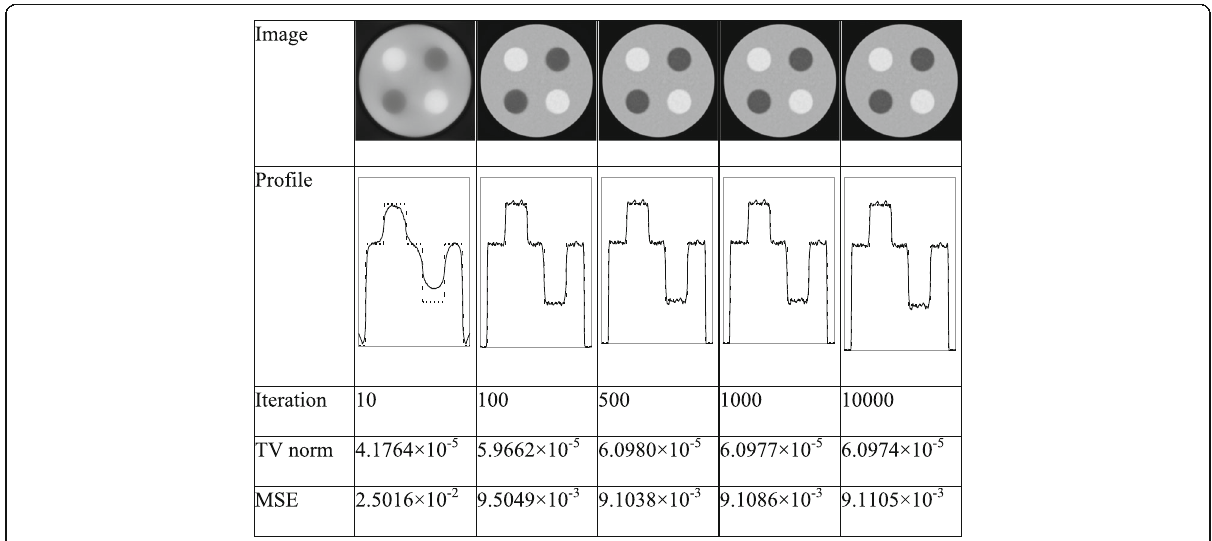
Fig. 6 Reconstructions of transmission data using algorithm (15) with β = 0.01 when I 0 =